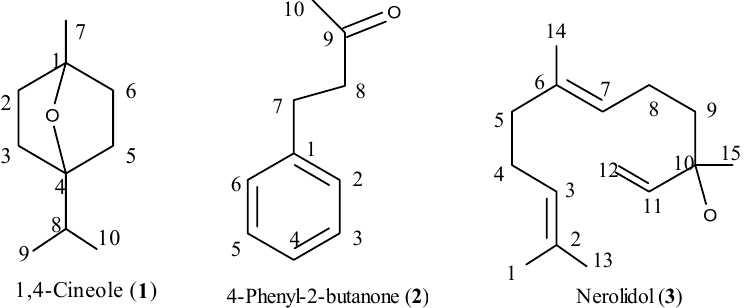
Figure 1. Structures of active compounds isolated from R. anthopogonoides flowering aerial